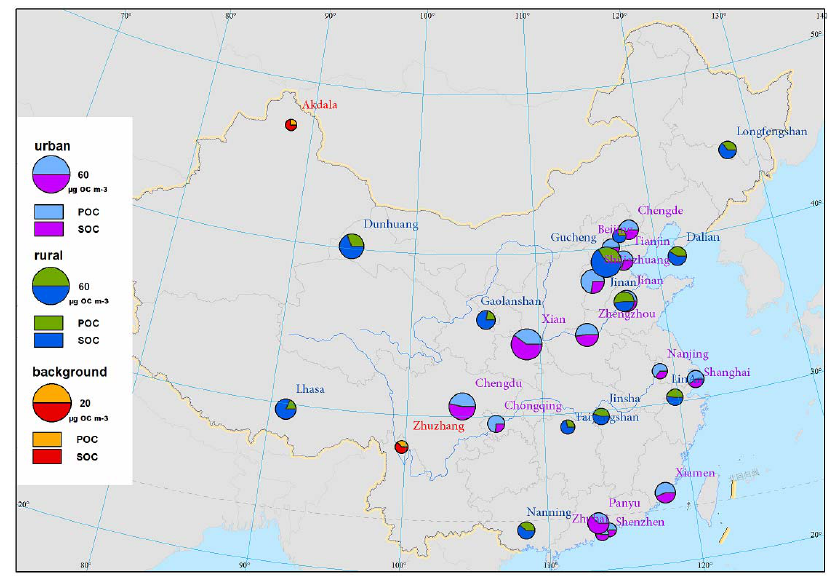
Figure 5. Annual averages of OC concentrations and mass fractions of POC and SOC to OC by region from various studies, including (1) urban sites: Beijing (Lin et al., 2009); Tianjin, Shijiazhuang, and Chengde (P. Zhao et al., 2013); Jinan (Yang et al., 2012); Guangzhou (Duan et al., 2007); Xiamen (Zhang et al., 2011); Shenzhen and Zhuhai (Cao et al., 2003a, 2004); Shanghai (Feng et al., 2009); Nanjing (Wu et al., 2013); Chongqing (Chen et al., 2014); Chengdu, Panyu, Xi’an, Zhengzhou, Nanning, and Dalian (X. Zhang et al., 2008); (2) rural sites: Jinan (Yang et al., 2012); Gucheng, Taiyangshan, Longfengshan, Dunhuang, Linan, Jinsha, Lhasa, Gaolanshan, and Shangdianzi (X. Zhang et al., 2008); and (3) remote sites: Akdala and Zhuzhang (Qu et al., 2009). SOC concentrations were obtained by original studies using the EC-tracing method (Eqs. 3 and 4; Castro et al., 1999). The minimum or the lowest 5–20% OC / EC ratios were used as the (OC / EC) pri (Cao et al., 2007). Note the scales of pie charts indicating OC concentrations are not uniform for urban, rural, and remote sites, to ease